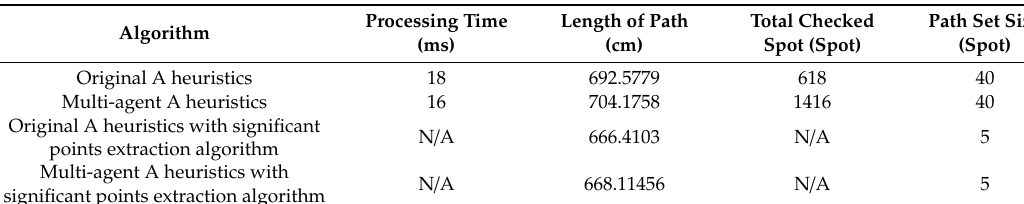
Table 4. Indices obtained by original A-heuristic algorithm and multi-agent–heuristic algorithm with or without the presence of a reduction path algorithm in the second scenario.